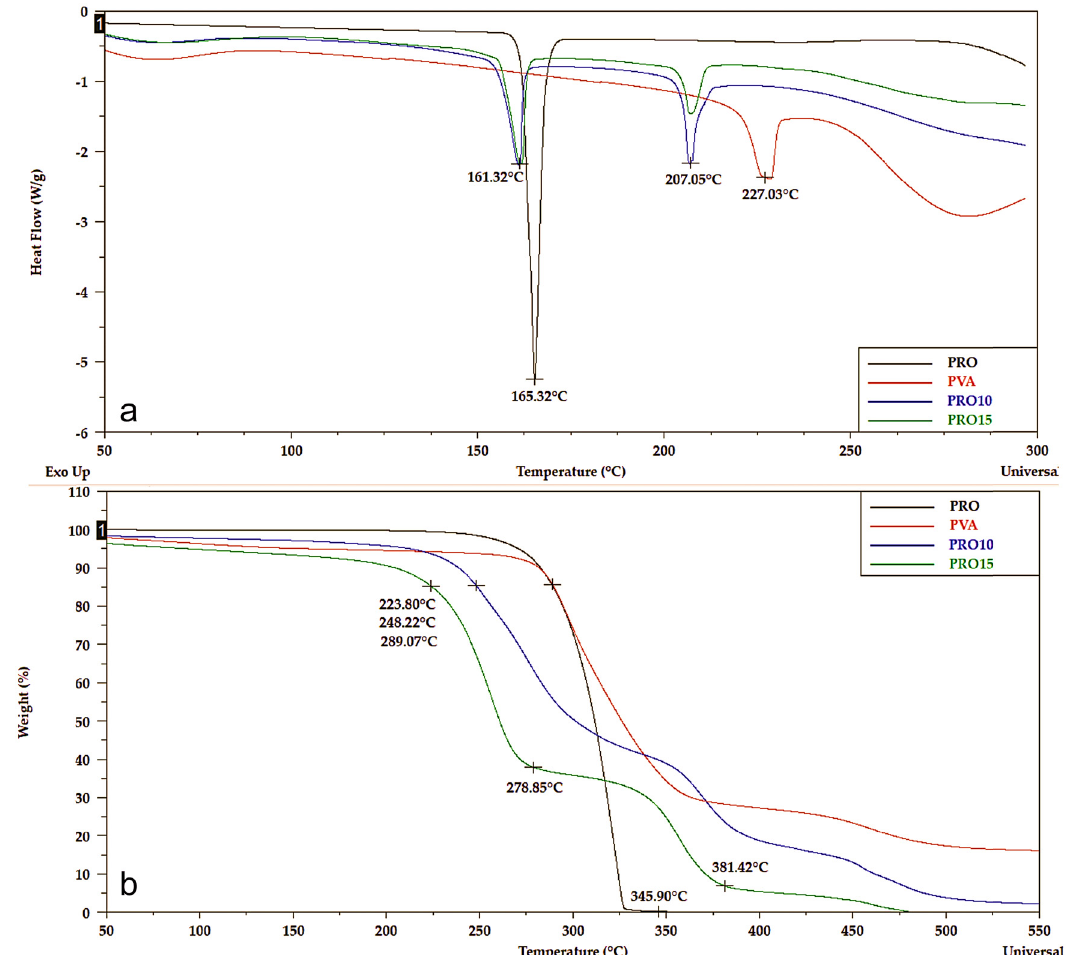
Figure 4: ( a ) DSC curves and ( b ) TGA thermograms of electrospun PVA, PRO 10, PRO 15, and PRO